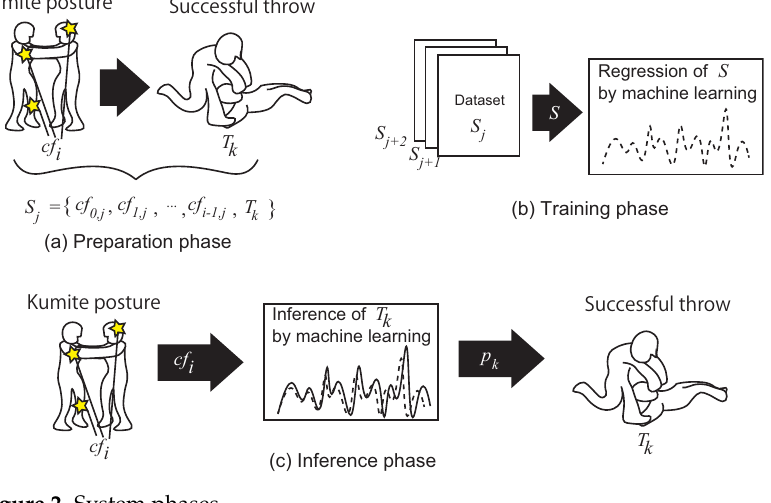
Figure 2. System